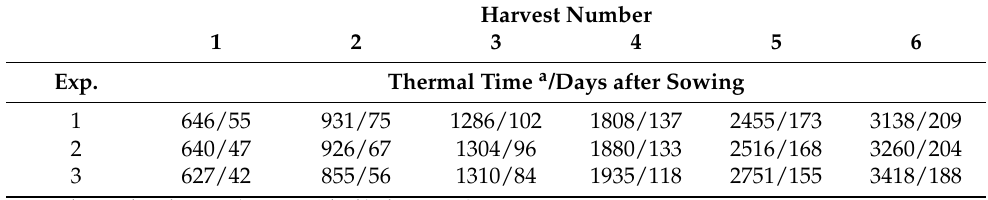
Table 6. Thermal time and days after sowing of each harvest of the specific experiment (exp.). Harvest